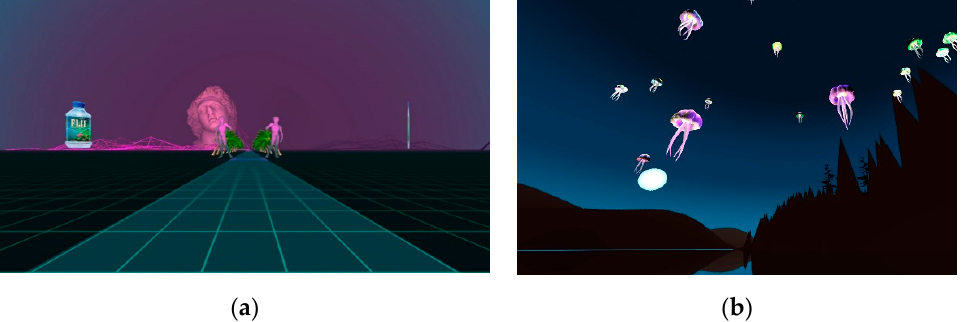
Figure 1. ( a ) Vaporscape: A Jorge Barros project inspired by the art of the album “Floral Shoppe” by Vektroid; ( b ) A WebVR adaptation of the collective TeamLab “Forest of Resonating Lamps—One Stroke” by Luisa Guedes.